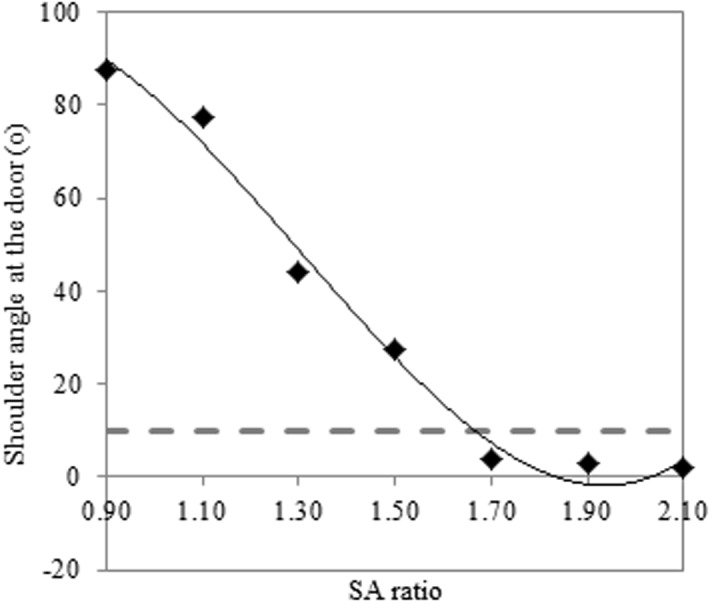
An illustration of the calculation of critical aperture.Data is shown from one participant, blank diamonds illustrate average shoulder angle at the door for each SA ratio and the black line shows the fitted polynomial curve. The dotted line illustrates average baseline sway + one standard deviation of baseline sway. Critical ratio is the point that the two lines intersect.